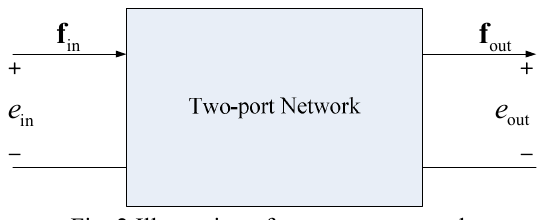
Fig. 2 Illustration of a two-port